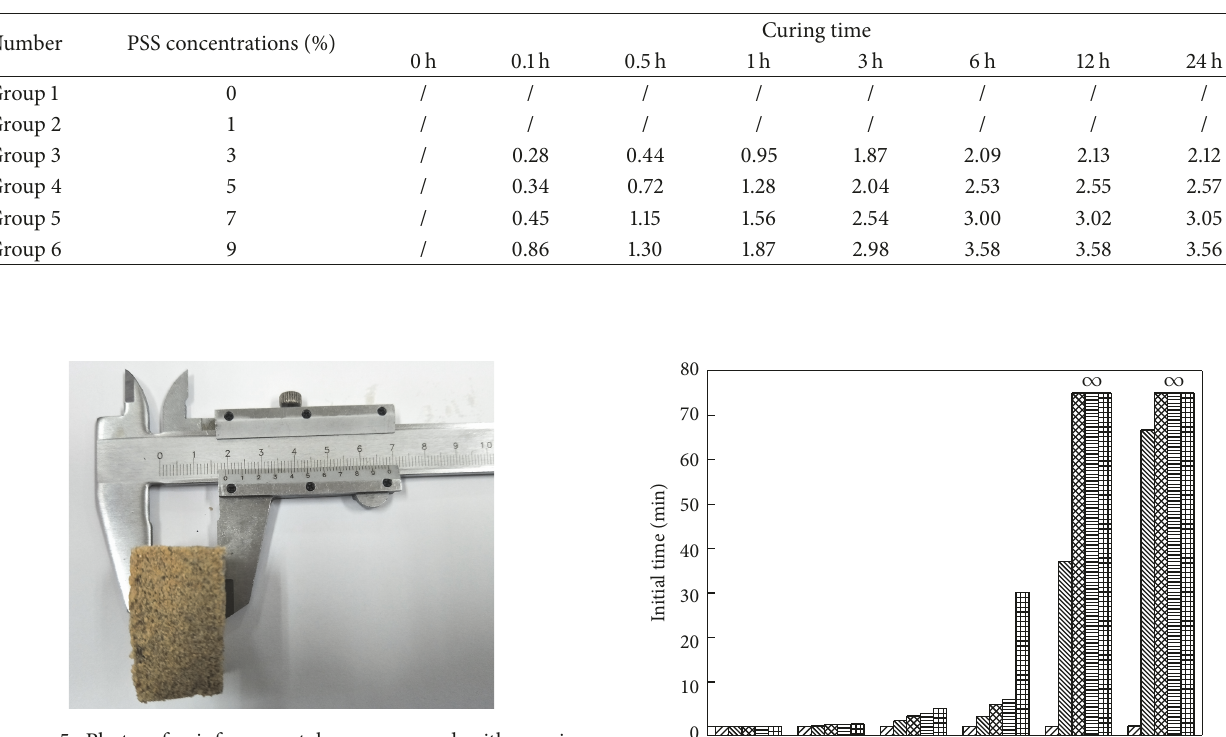
Figure 5: Photo of reinforcement layer measured with vernier caliper.